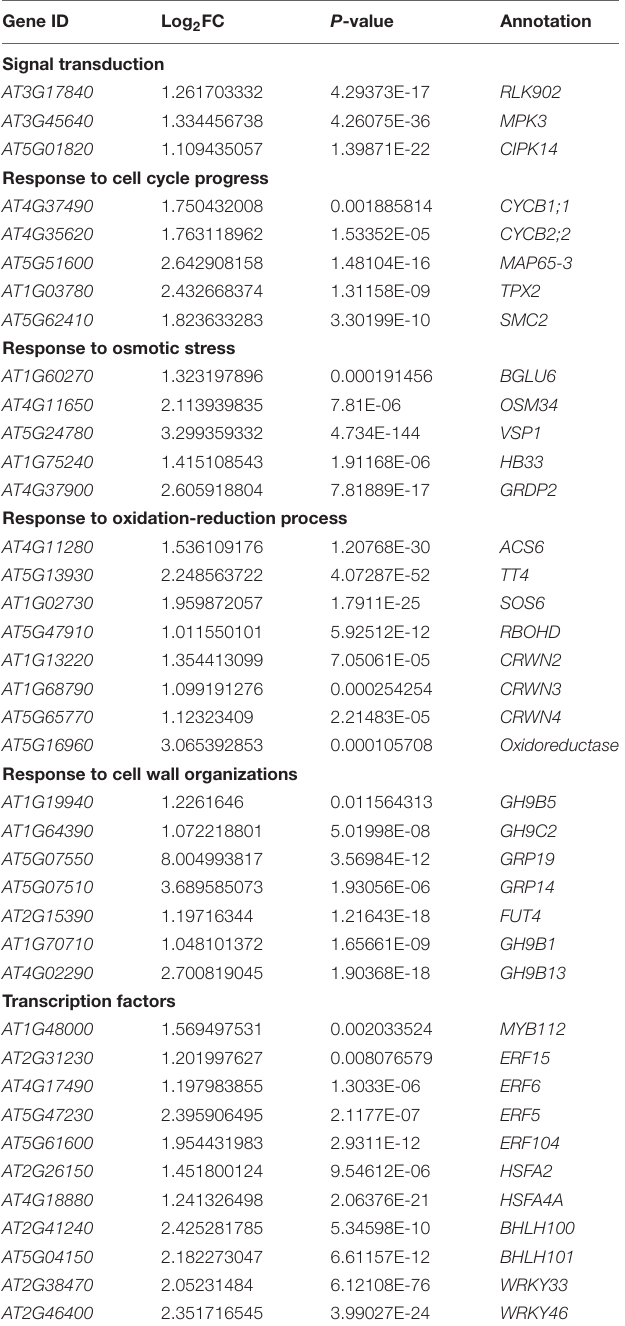
TABLE 1 | Expression levels of DEGs from different biological processes in HW vs.